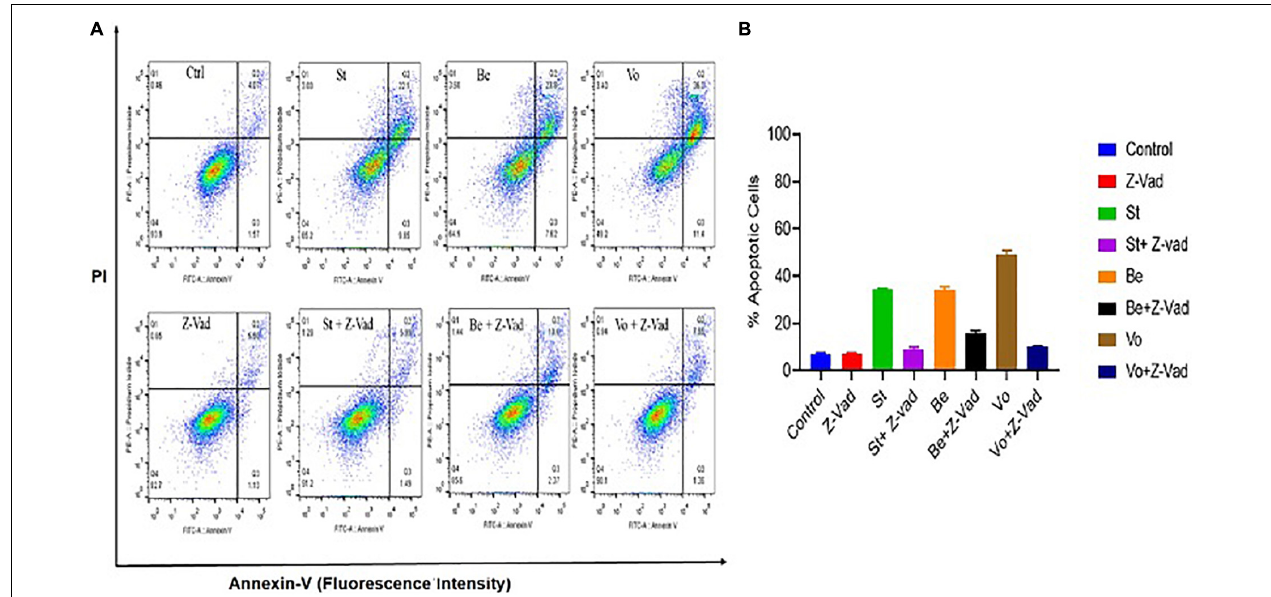
FIGURE 4 | Histone deacetylase inhibitors (HDACi) treatment induces caspase-dependent apoptosis in the Theileria infected cells. (A) The percentage of apoptosis was quantified by flow cytometry analysis using annexin V and PI staining. (B) Quantitative analysis of the apoptotic cells based on an average of three independent experiments (mean ±